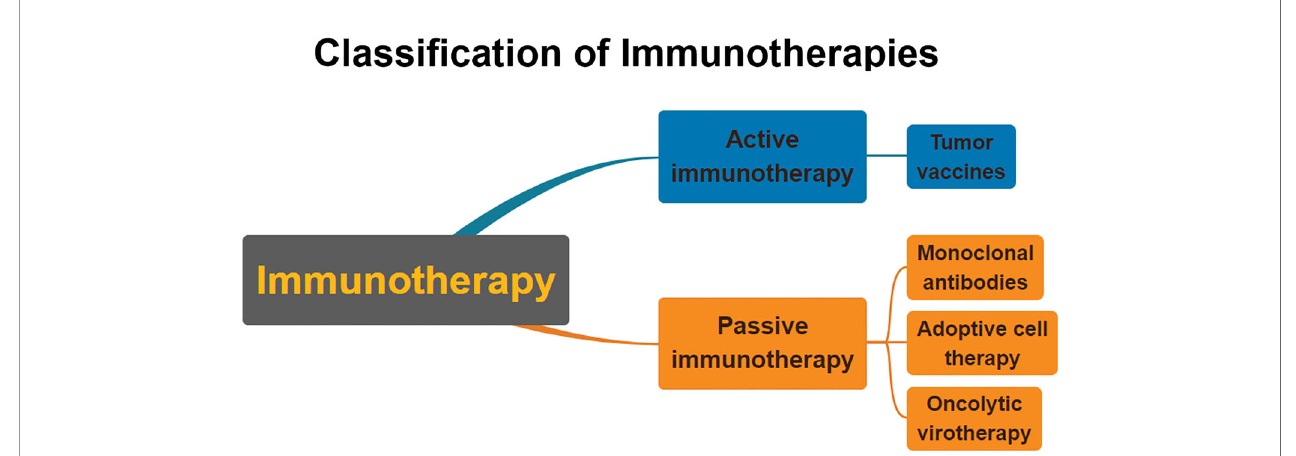
FIGURE 1 | Classi fi cation of immunotherapies. Immunotherapy is usually divided into passive immunotherapy and active immunotherapy. Active immunotherapy is mainly cancer vaccines. Passive immunotherapy mainly includes adoptive cell therapy, oncolytic viruses, and monoclonal